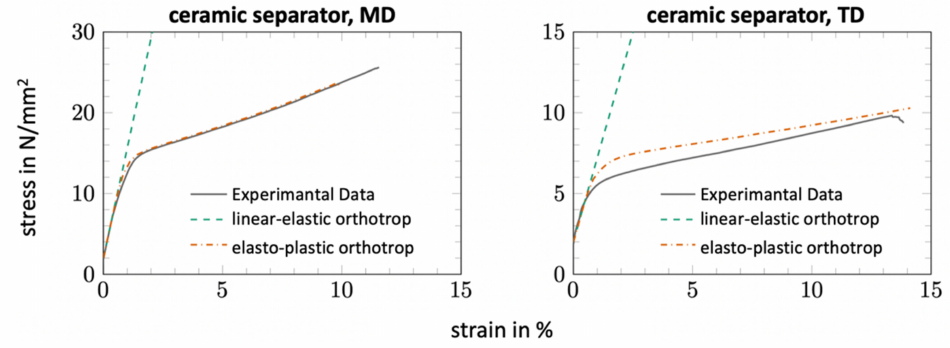
Figure 17. Stress–strain curves of different material models for ceramic separator in MD and TD [8]. 5. Step—Model and simulate sub-process | The simulation-based investigation of material behavior for different process and machine parameters as well as materials and formats require an idealized model of the real z-folding process. The following idealization is used for modeling (Figure 18):